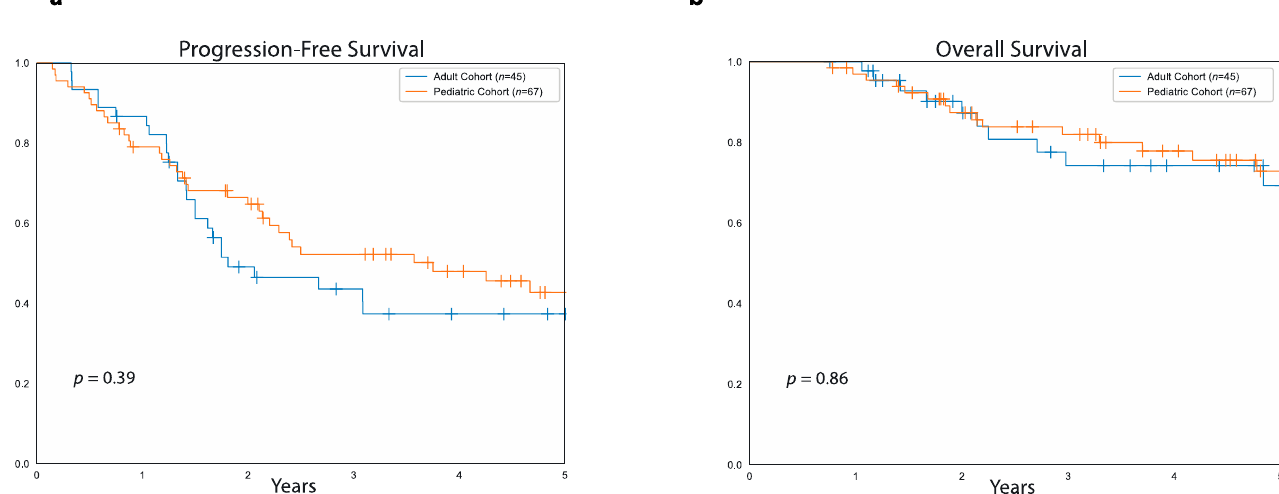
Figure 6. PFS and OS in the adult versus the pediatric cohort. ( a ) Progression-free survival in patients of the adult cohort (blue curve) and patients of the pediatric cohort (orange curve). ( b ) Overall survival in patients of the adult cohort (blue curve) and patients of the pediatric curve (orange curve).